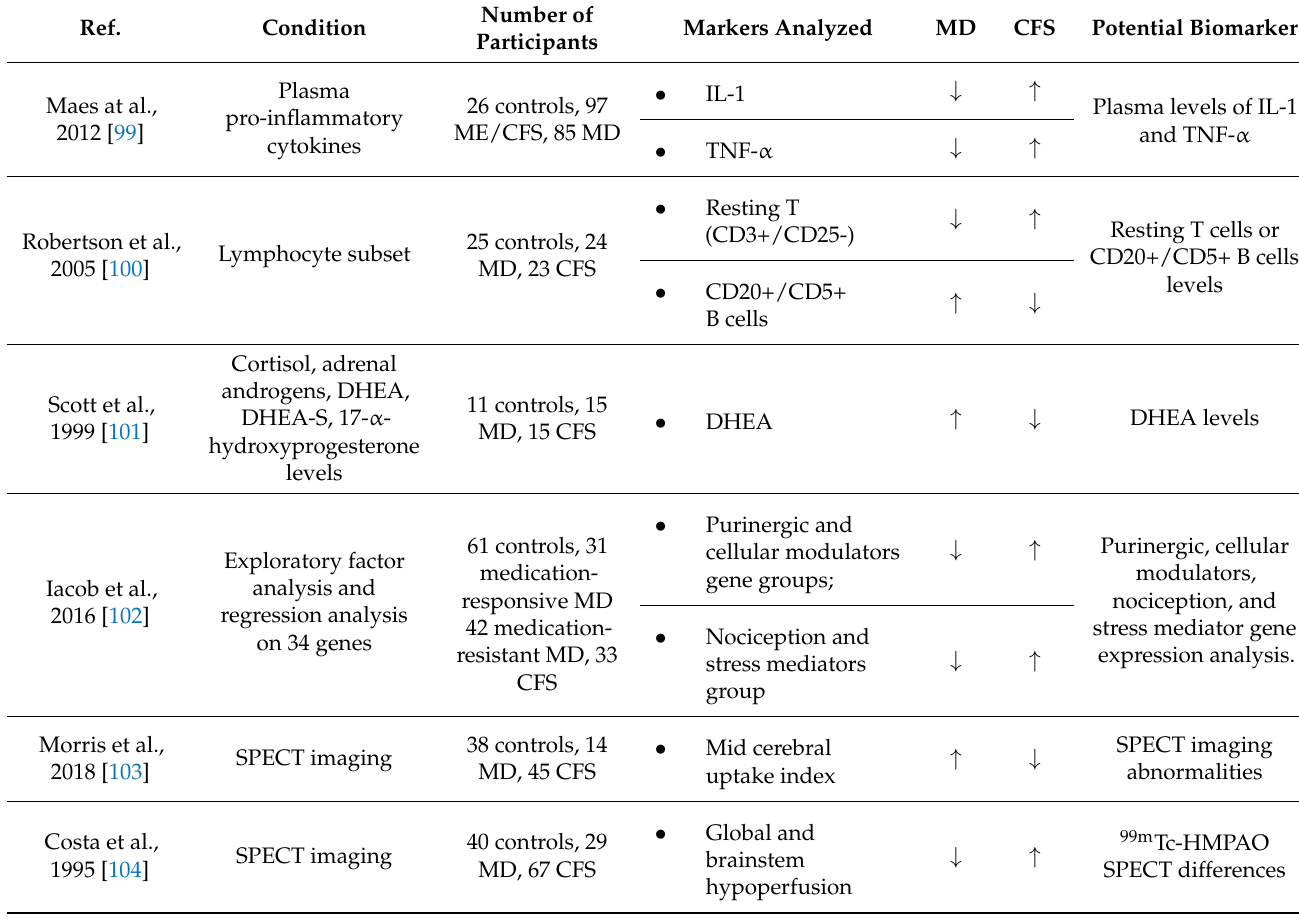
Table 2. Proposed biomarkers for CFS/MD differential